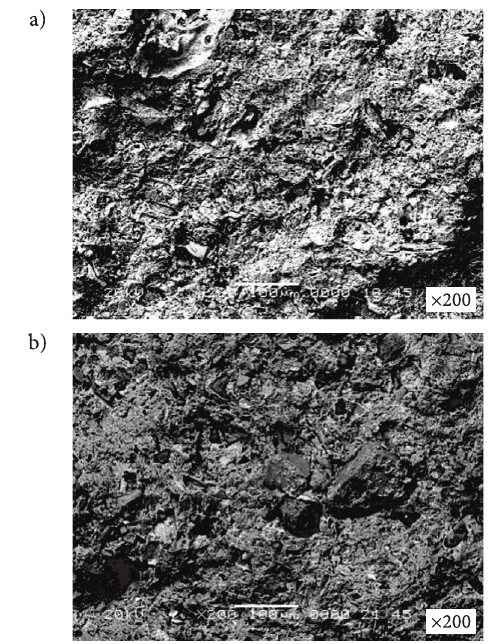
Fig. 7. Electron microscopic image of the surface of the fired samples of